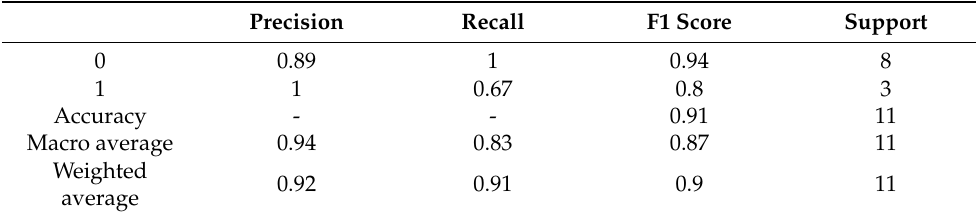
Table 2. Results from the random forest algorithm and parameter settings.